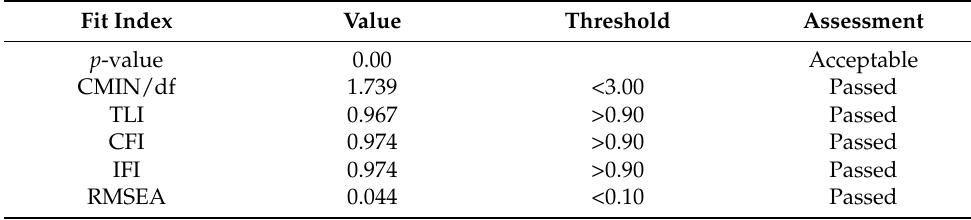
Table 5. The goodness of fit of the measurement